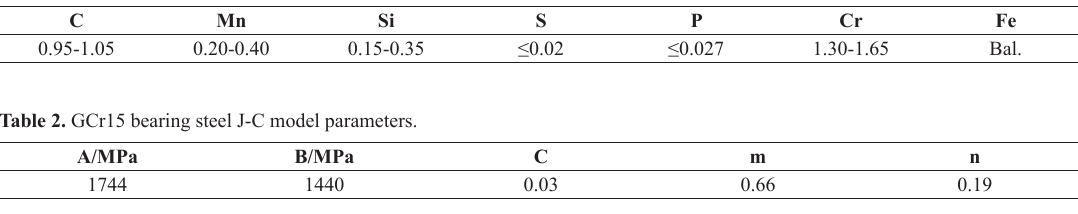
Table 1. Main chemical composition of GCr15 steel (wt%).